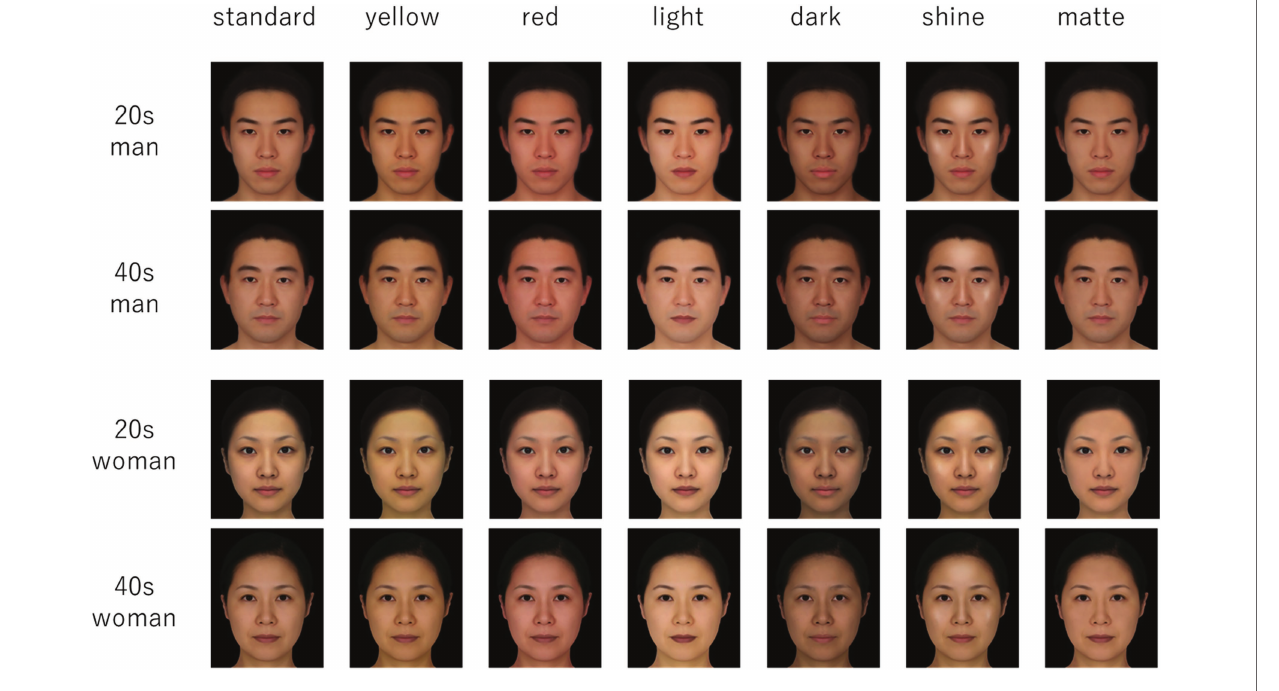
FIGURE 1 | Facial photographs used in both